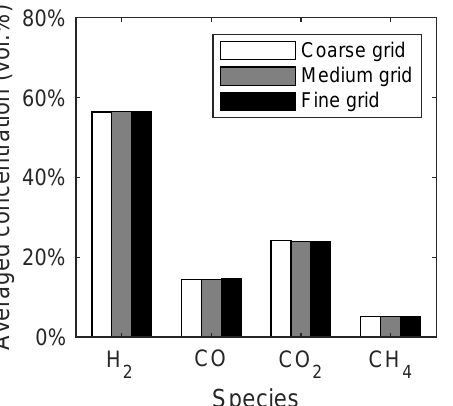
Figure 4. Syngas composition of the spouted bed depending on the grid resolution.